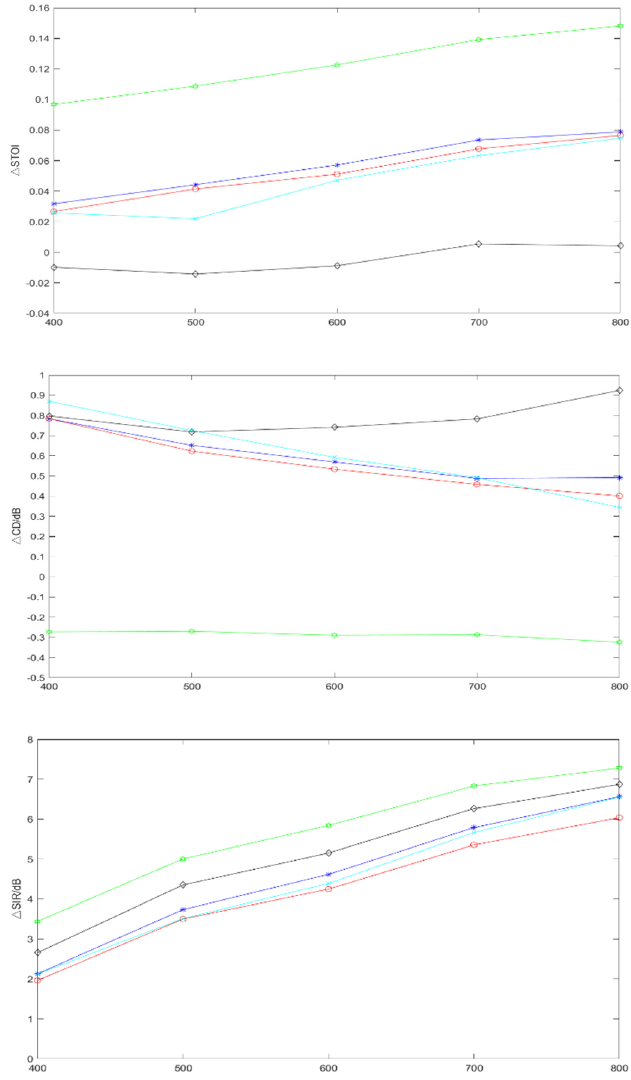
Figure 4. Test results related to T 60 on four initialization methods of the PSD of the desired signal with real PSD (green line), [14,15] (black line), proposed (red line), ISCLP (blue line), and [34] (cyan line).